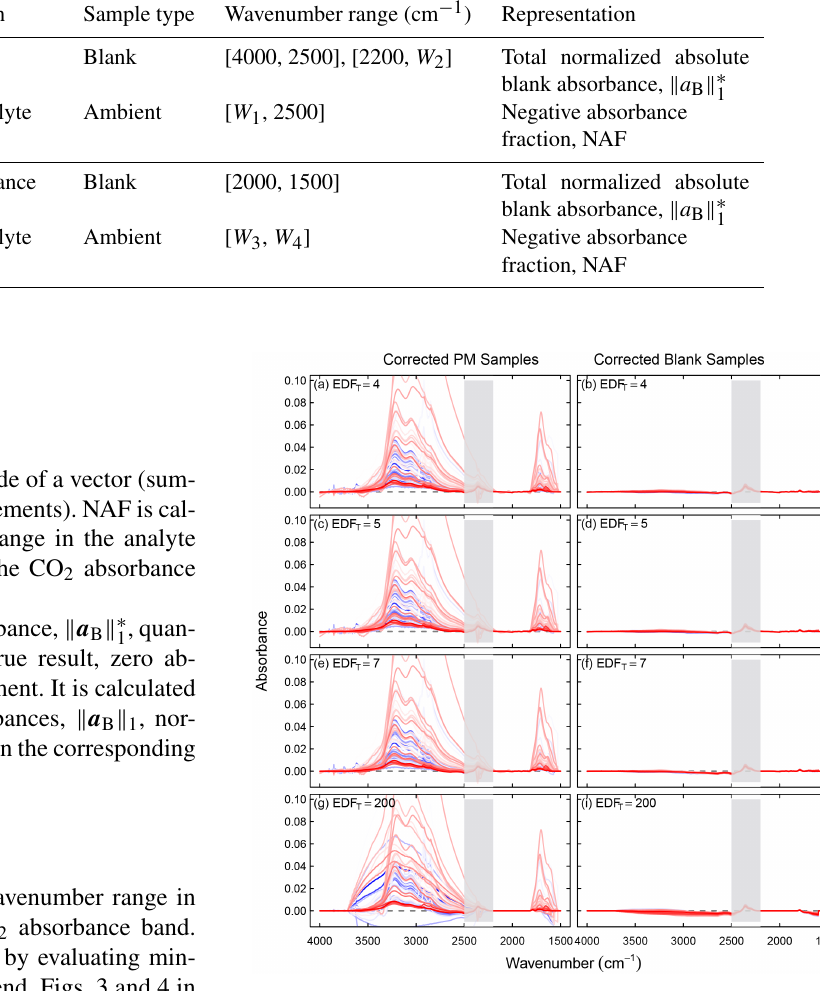
Figure 3. 54 randomly selected ambient samples (left) and 54 blank samples (right) corrected by varying EDF T . Each spectrum is color-differentiated. The CO 2 absorption band between 2500 and 2220cm − 1 not associated with PM composition is shaded in color. The x axis ranges from 4000 to 1500cm − 1 in both left and right